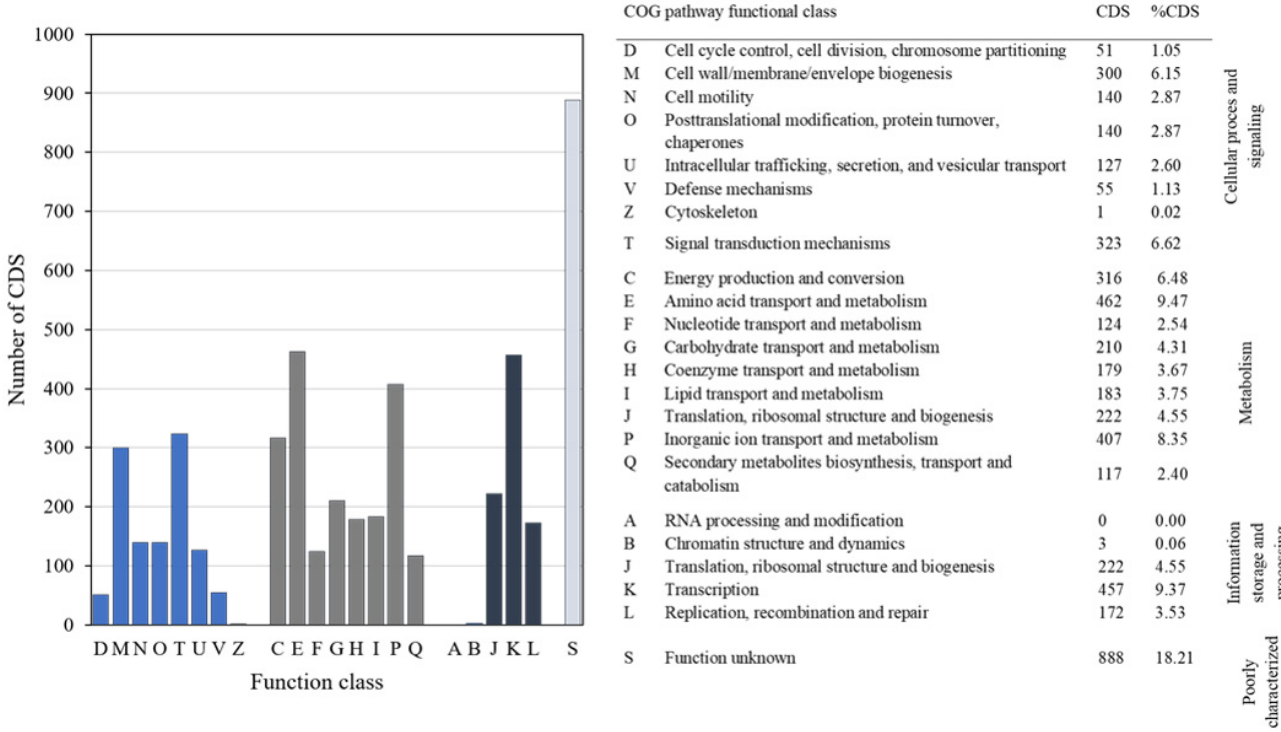
Figure 3. COG classification of predicted genes in the ZCR6 strain. Colored bars indicate the CDS assigned to each COG category.